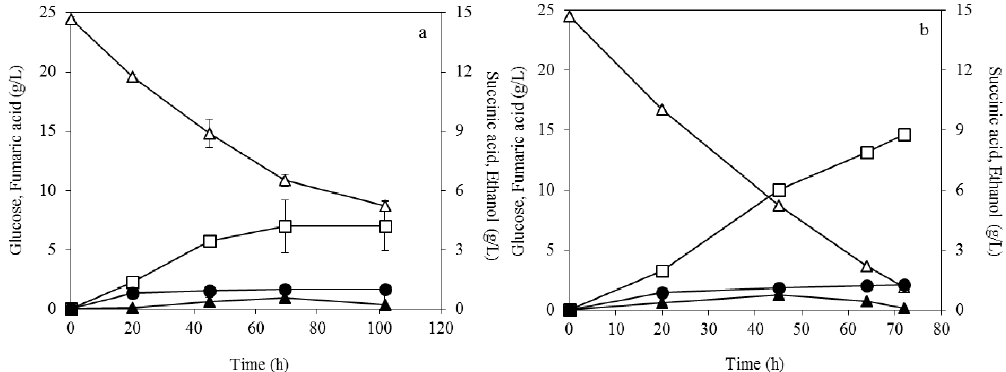
Figure 1. E ff ect of pellet morphology on fumaric acid ( □ ), ethanol ( ▲ ) and succinic acid ( ● ) production during submerged fermentation of R. arrhizus NRRL 2582 at 25 g/L initial glucose concentration ( △ ). The initial ammonium sulphate concentration was ( a ) 0.04 g/L and ( b ) 0.2 g/L.